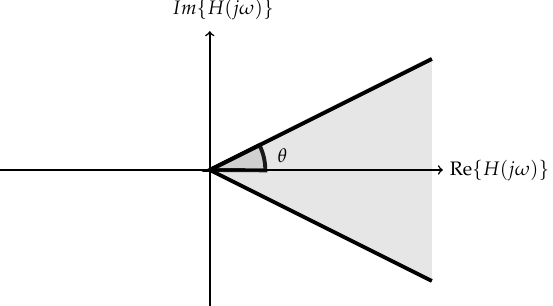
Figure 1. Conic sector with the inner angle 2 θ